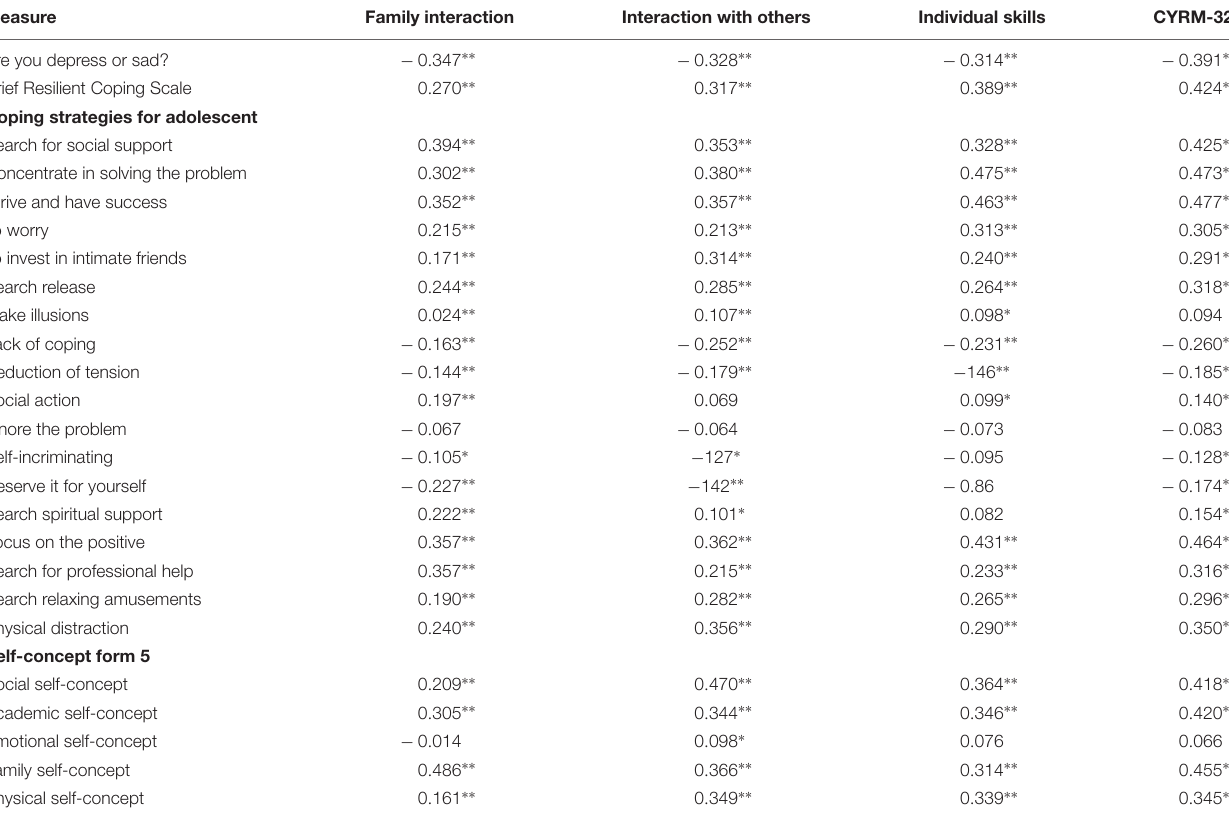
TABLE 5 | Correlations between dimensions of CYRM-32 and others measures. Measure Family interaction Interaction with others Individual